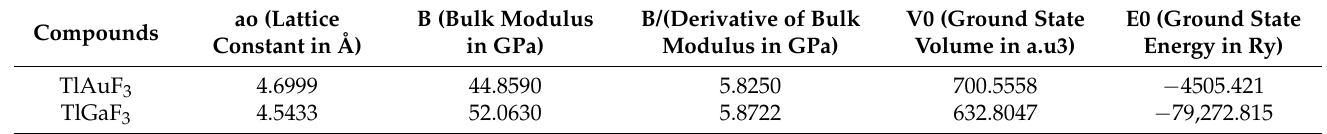
Figure 4. ( a ) Total and partial density of states of TlAuF 3 , ( b ) Total and partial density of states of TlAuF 3 . Table 1. Computed optimized structural properties of TlMF 3 (M = Au, Ga) from the energy vs. volume fixed by